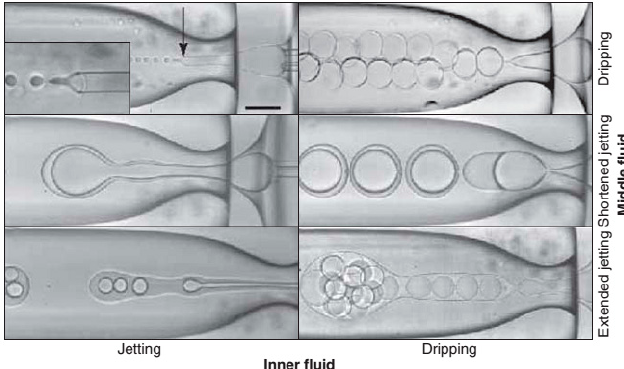
Figure 7. Different morphologies of double emulsions produced by a microcapillary device [109]. Reproduced with permission from Utada, A.S., et al., MRS Bulletin ; published by Cambridge University Press, 2007.